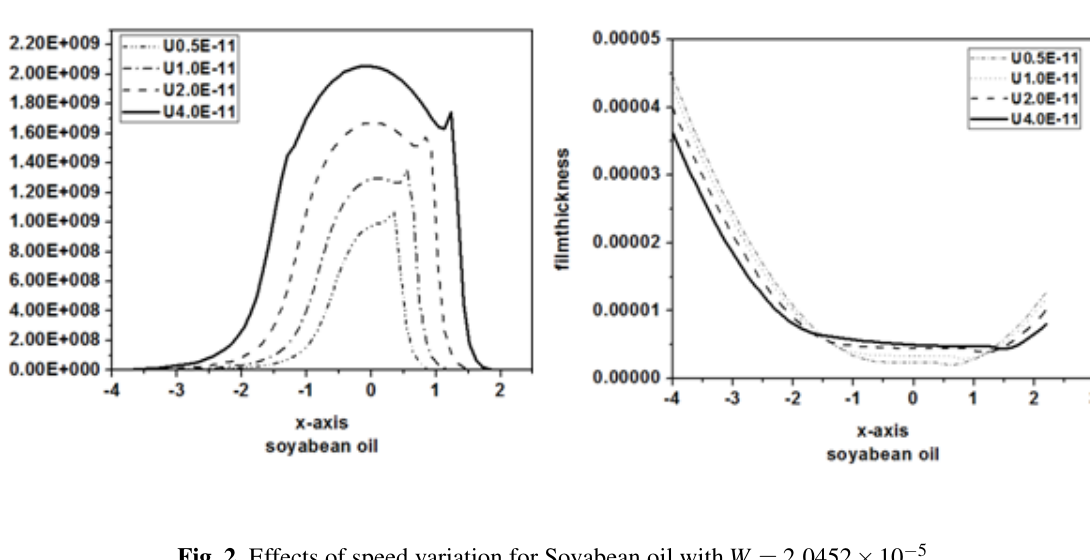
Table 3 Effect of dimensional load and speed on dimensional pressure and filmthickness.